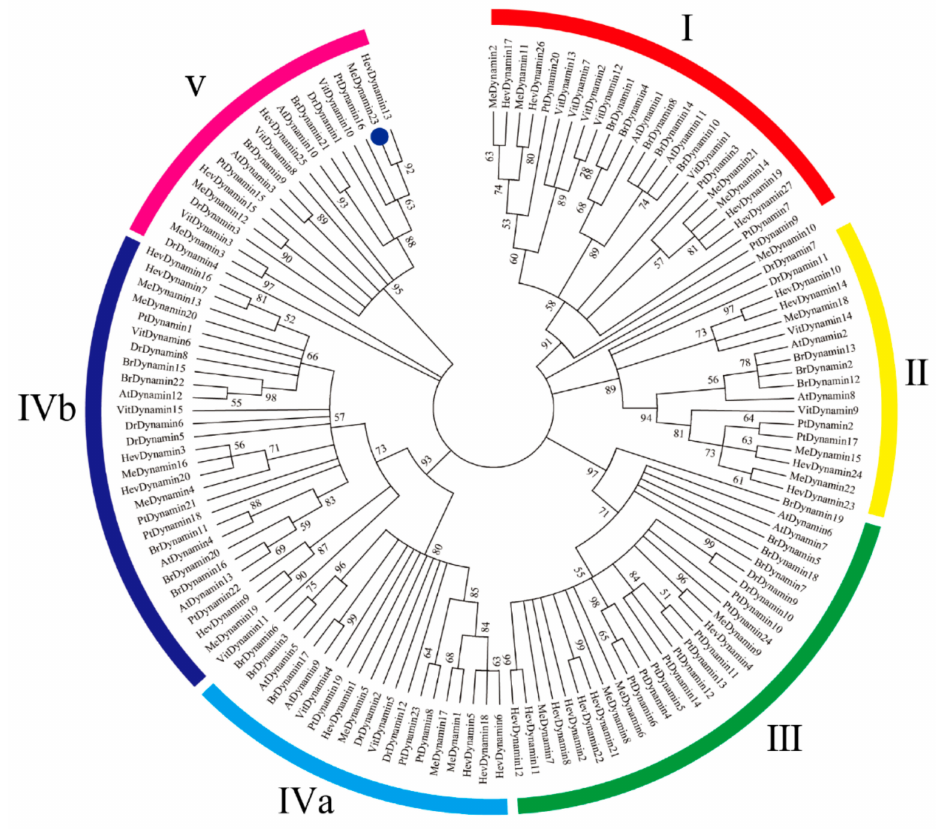
Figure 1. Unrooted phylogenetic tree representing relationships among Dynamin domains of six species. The di ff erent-colored arcs and roman numerals indicate di ff erent groups (or subgroups) of Dynamin domains. The blue solid circles represent ARC5 from